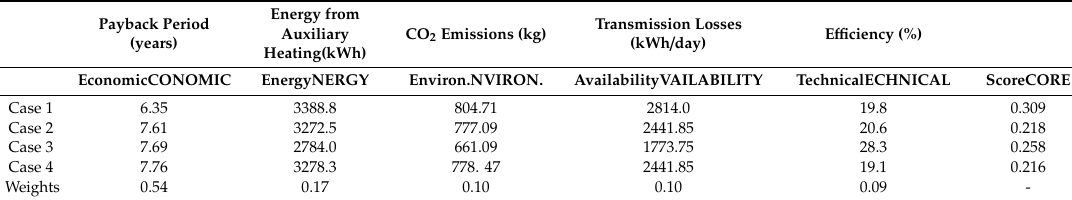
Table 9. Values for criteria, weights, and total scores for the